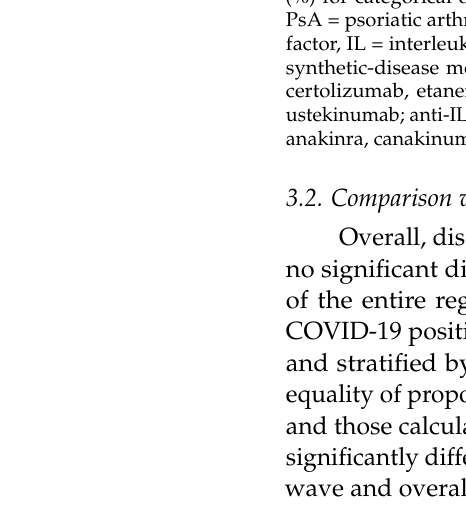
Table 2. Cases and proportion of COVID-19 among different populations.